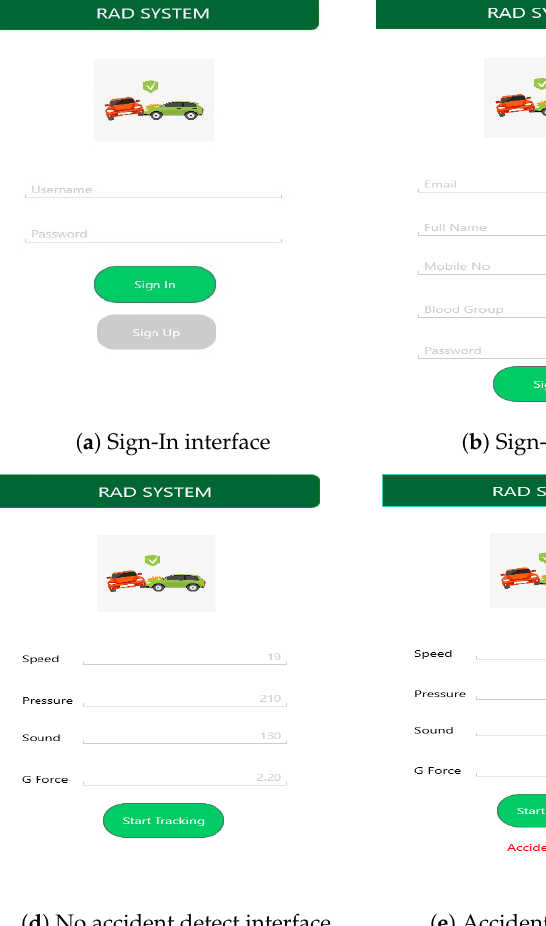
Figure 5. Andriod application